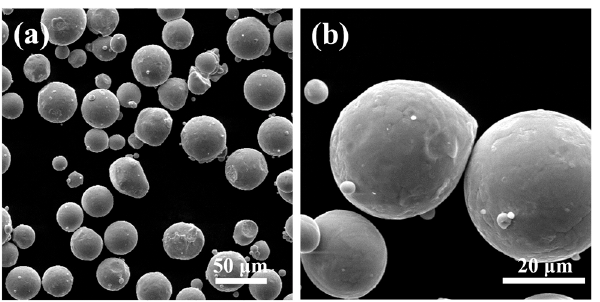
Figure 3. SEM micrographs of Ti–6Al–4V powder, ( a ) ×500 and ( b ) ×2000.